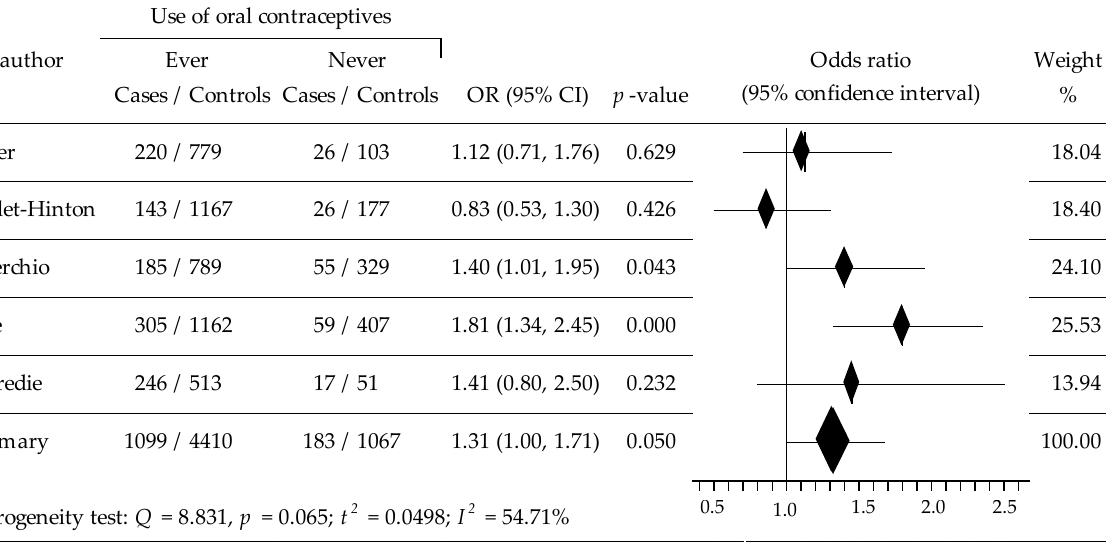
Figure 3. Forest plot for the association between OC use and the risk of ER − BC.